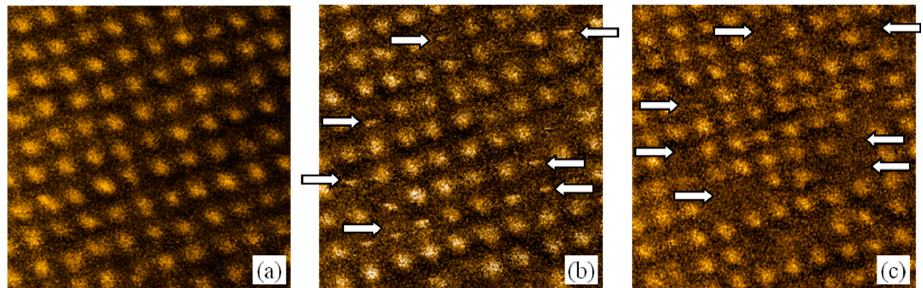
Figure 7. The successive MFM images of magnetic bubble array in Co/Pt. ( a ) The initial state of uniformly magnetized array; ( b ) The MFM imaging with low scanning height. The places of sharp switching of MFM contrast are indicated by white arrows; ( c ) The final state of magnetic bubble array after the MFM probe switching. The switched bubbles are indicated by white arrows. The MFM frame size is 2 μ m × 2 μ m. The MFM contrast is normalized to the maximum.